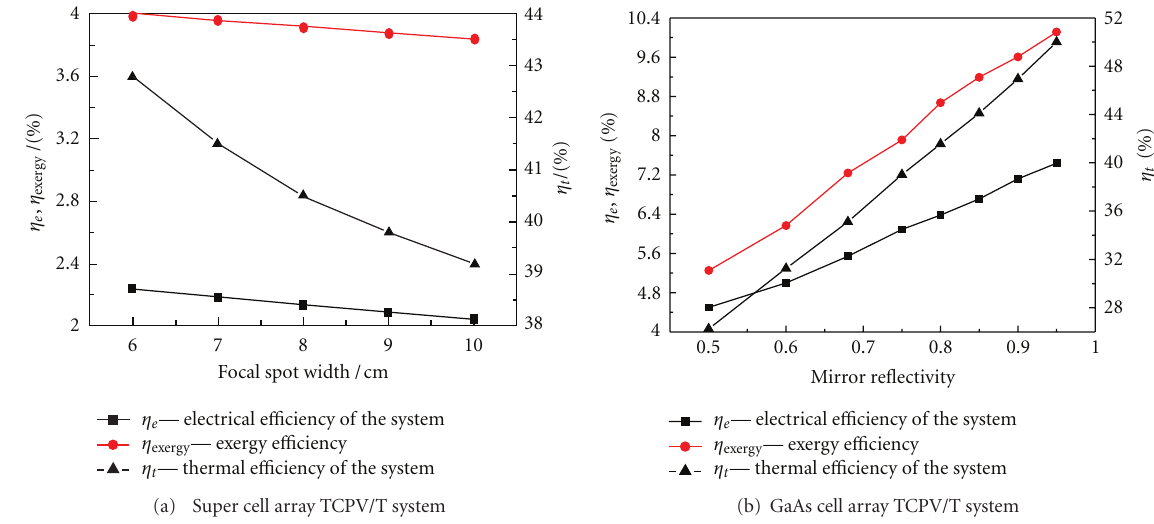
Figure 7: The influences of mirror reflectivity on the system performances.